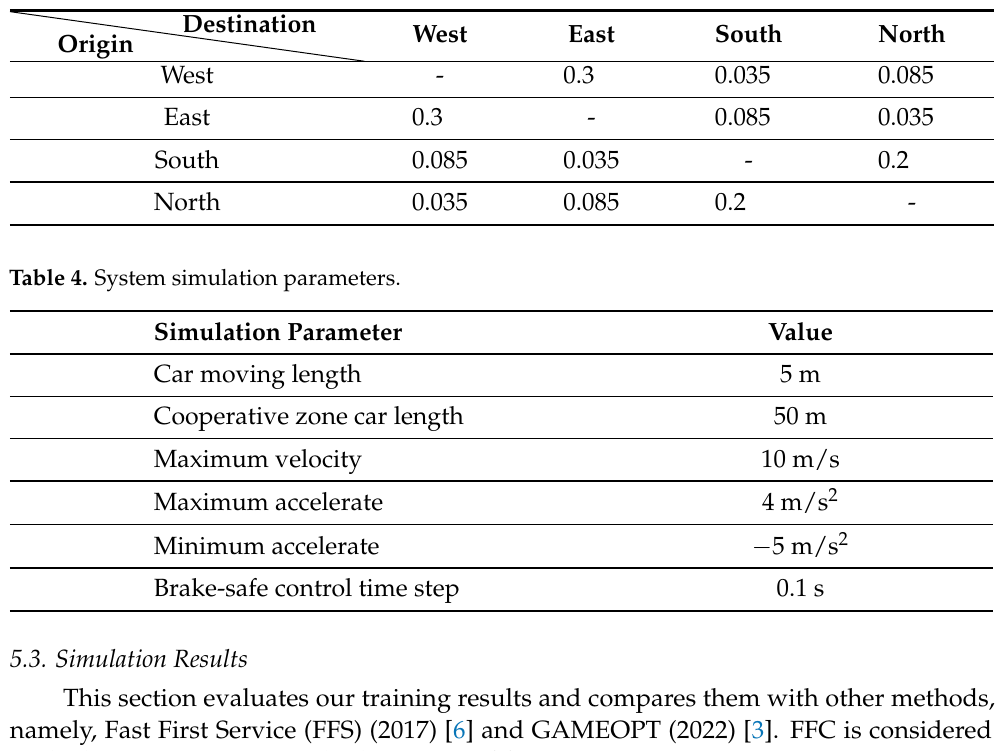
Table 3. Origin–Destination matrix.